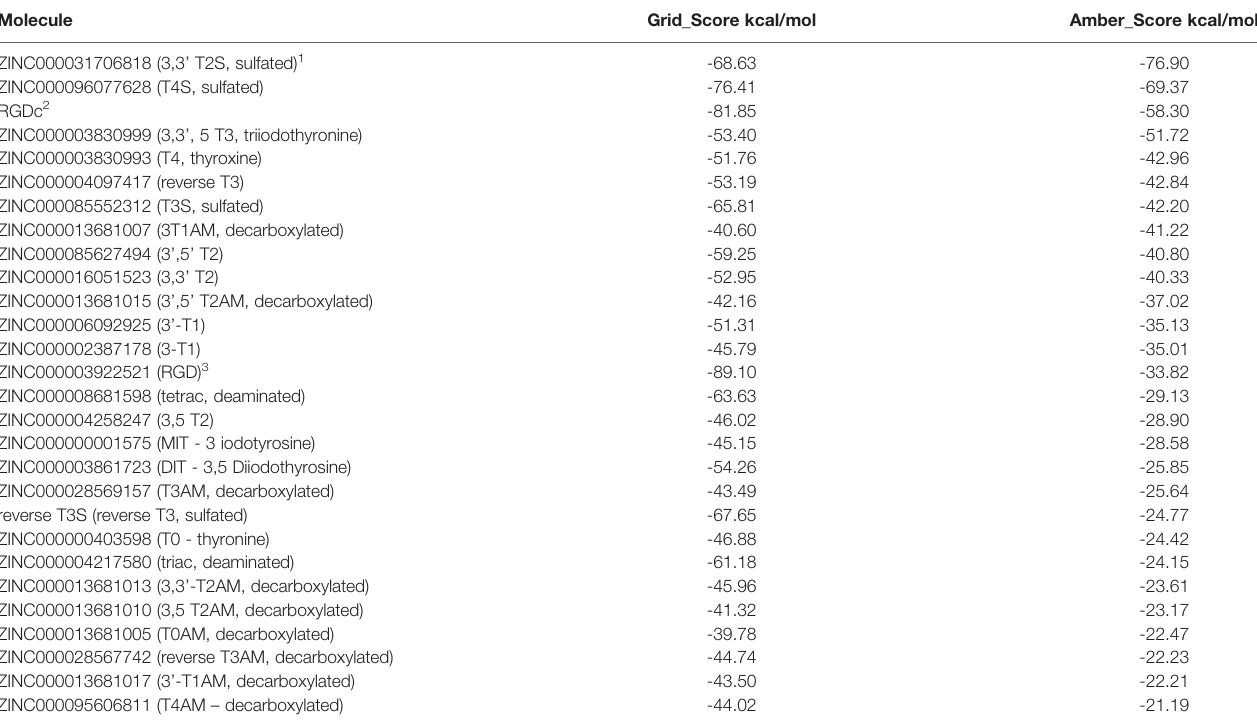
TABLE 1 | Grid Amber score for thyroid hormone